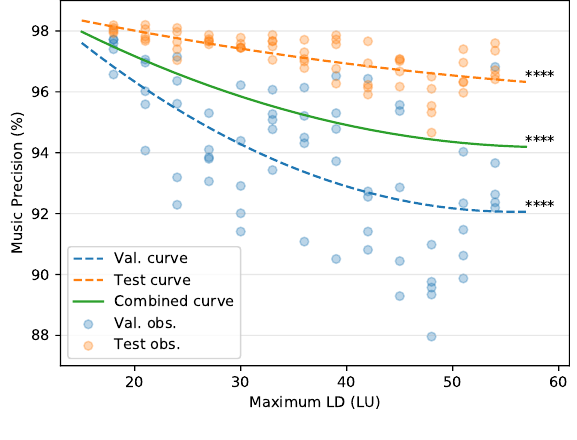
Val. curve Test curve Combined curve Val. obs. Test obs.